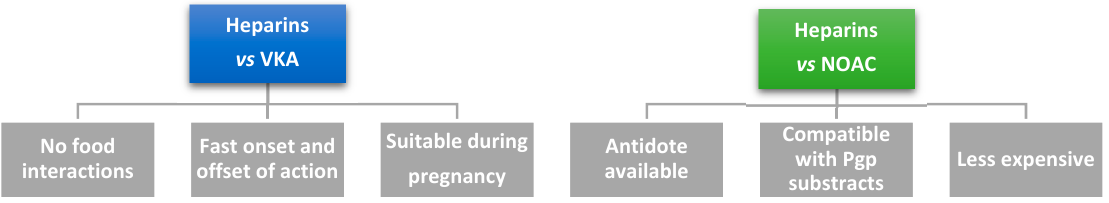
Figure 2. Advantages of heparins over vitamin K antagonists (VKA) and new oral anticoagulants (NOACs)